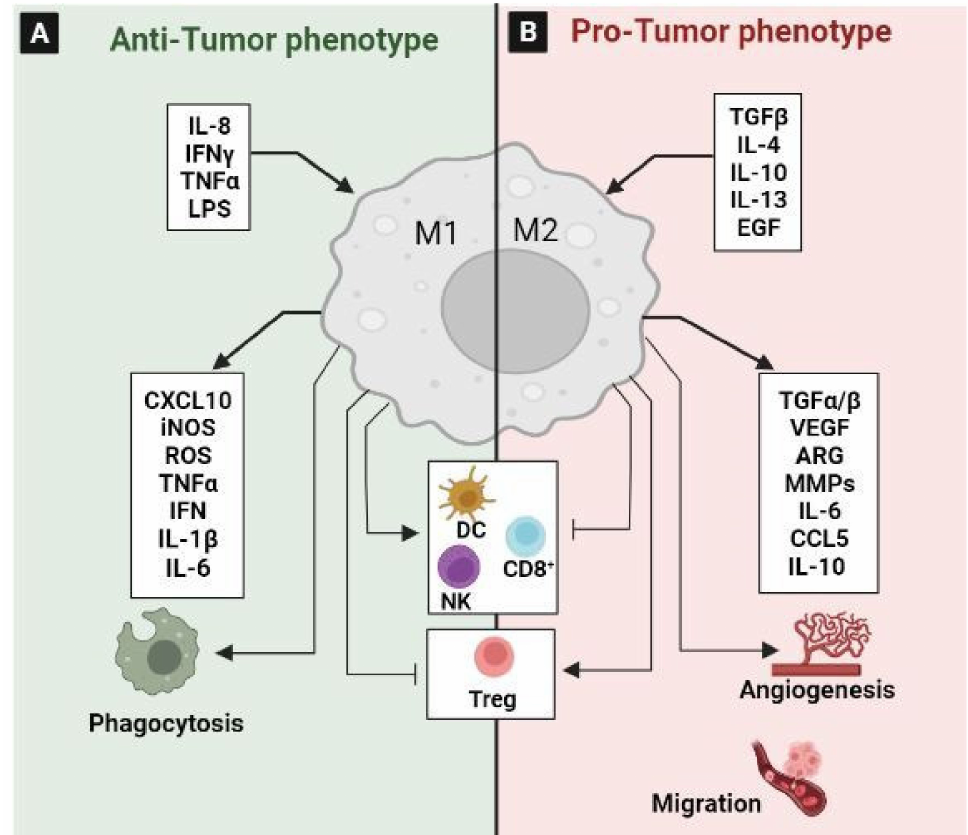
Figure 8. The role of tumor-associated macrophages (TAM) in the tumor microenvironment. Macrophages polarize to anti-tumoral M1 and pro-tumoral M2 phenotypes: Depending on the microenvironmental stimuli, TAMs exhibit anti-tumorigenic “M1” and the pro-tumorigenic “M2” phenotypes. ( A ) M1 macrophages are stimulated by IL-8, IFN γ , TNF α , or LPS. The stimulation of M1 macrophages triggers many downstream factors, such as CXCL10, iNOS, ROS, TNF α , IFN, IL-1 β , and IL-6. These factors activate a pro-inflammatory response, stimulate tumor cell recruitment into tumors and inhibit Treg recruitment. In addition, M1 macrophages can exhibit an anti-tumor effect by phagocytosing tumor cells. ( B ) M2 macrophages are stimulated by TGF β , IL-4, IL-10, IL-13, or EGF. This activation leads to the induction of downstream factors such asTGF α / β , VEGF, ARG, MMPs, IL-6, CCL5, and IL-10, which allow the M2 macrophage to play the role of a pro-tumor. Indeed, M2 macrophages induce angiogenesis and cell migration. They exert the function of